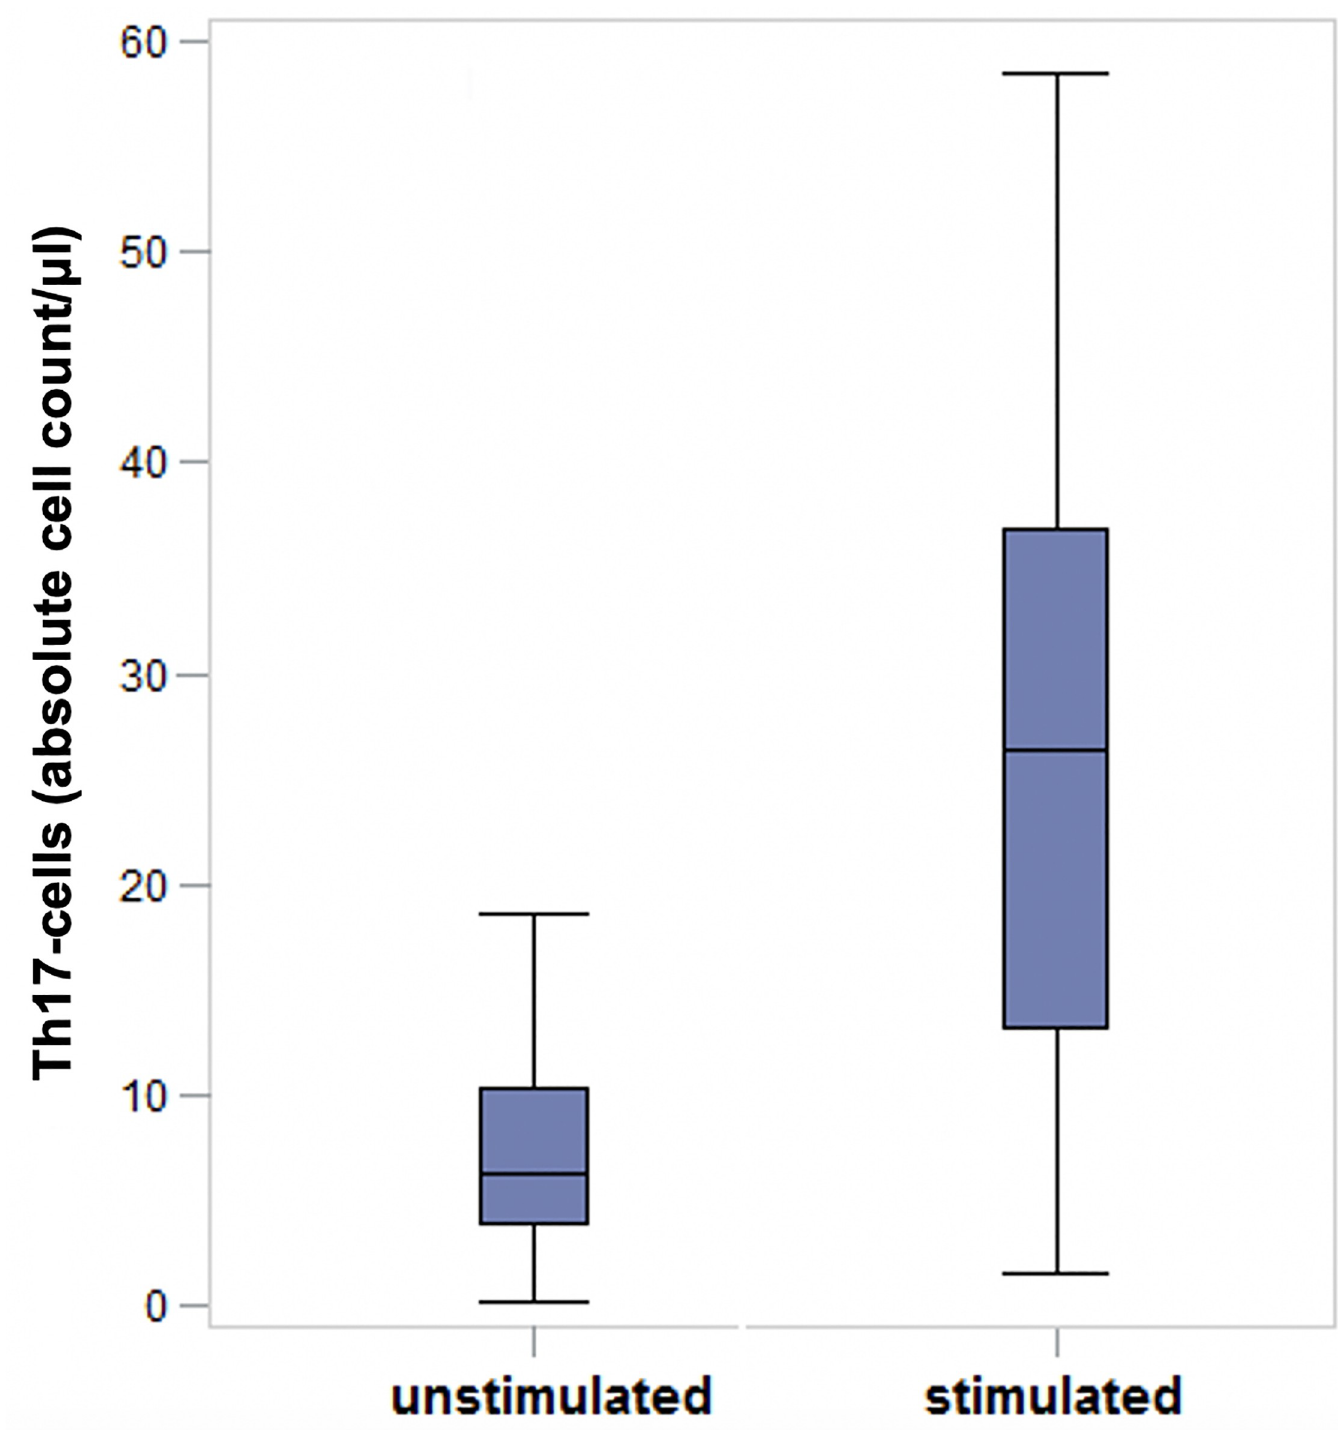
Fig 2. Results of unstimulated and stimulated Th17 cells of dogs suffering from IVDH (preoperatively). After cell stimulation with PMA, Ionomycin and Brefeldin A in peripheral blood samples of dogs suffering from intervertebral disc herniation (preoperatively) the number of Th17-cells was significantly higher in stimulated samples (p < 0.0001). Stimulation of Th-17 cells results in better analyzability and thus more exact measurements which makes it possible to detect significant differences. 62 samples consisting of each, a stimulated and an unstimulated sample = 124 samples in total.). Th17-cells: T-helper 17 cells; IVDH: Intervertebral disc herniation; μ l: